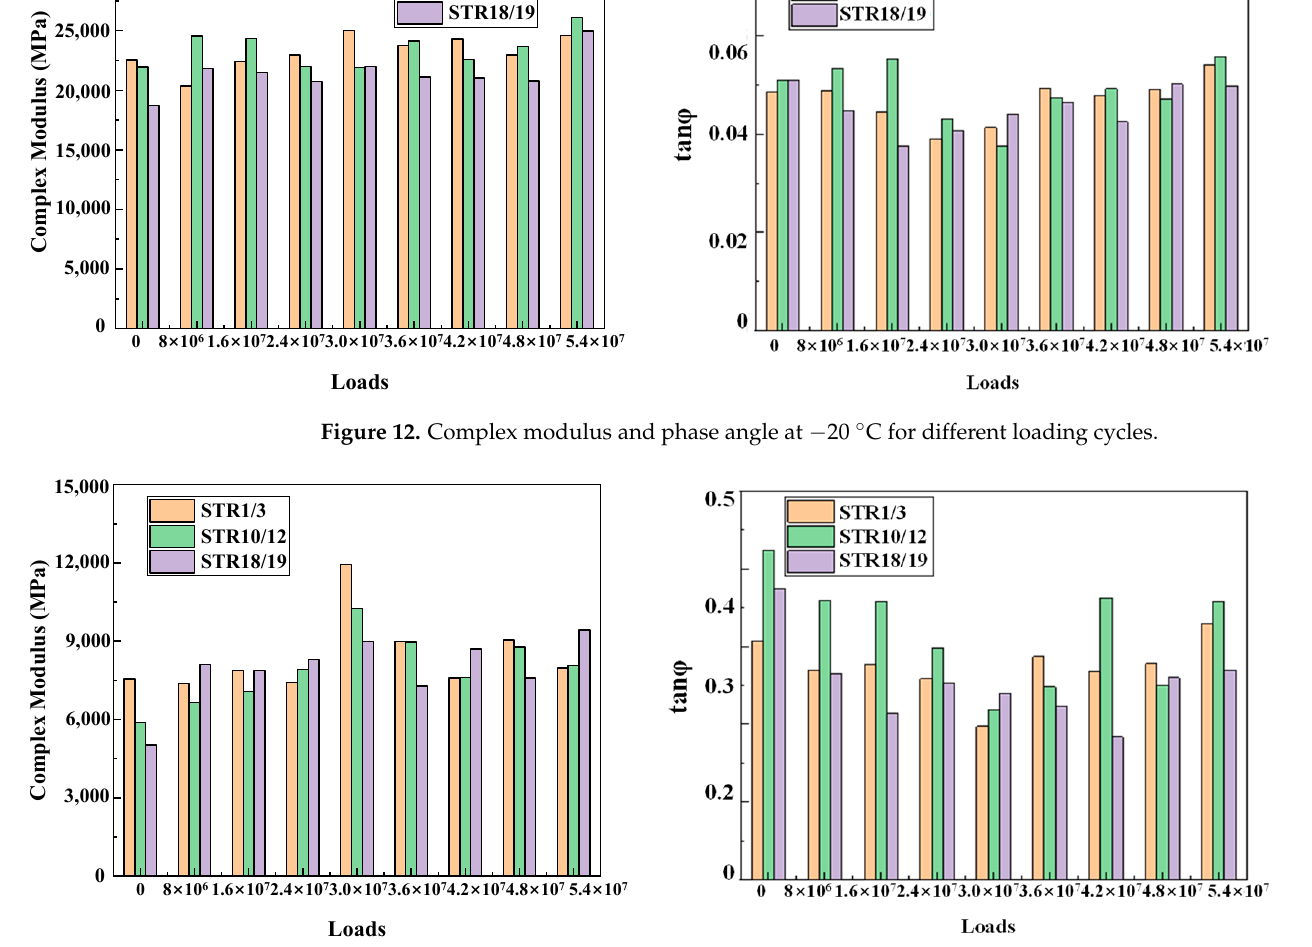
Figure 13. Complex modulus and phase angle at 20 °C for different loading cycles.